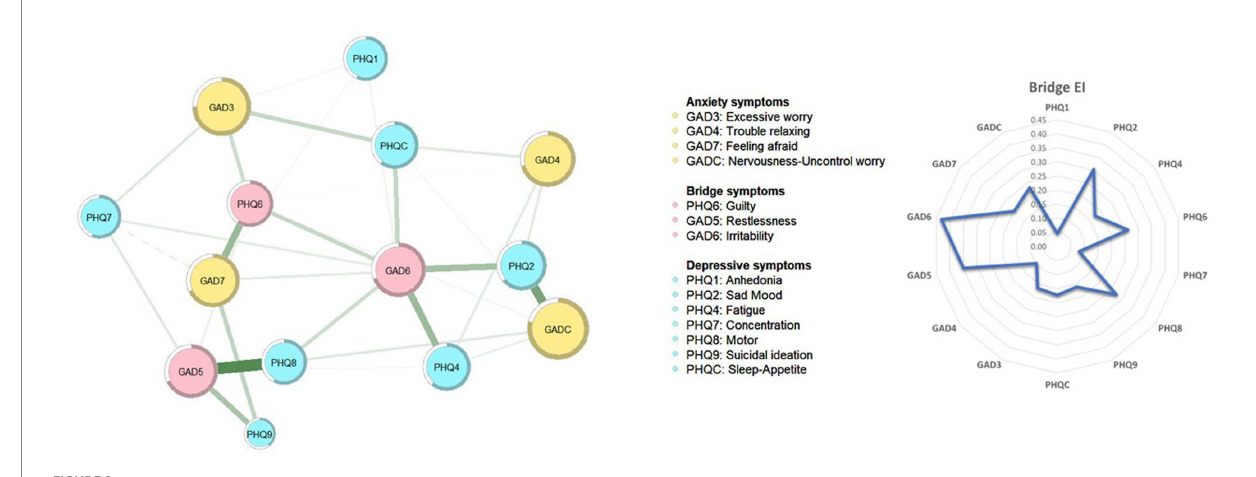
FIGURE 2 Bridge symptoms of depression and anxiety model in Macau residents.